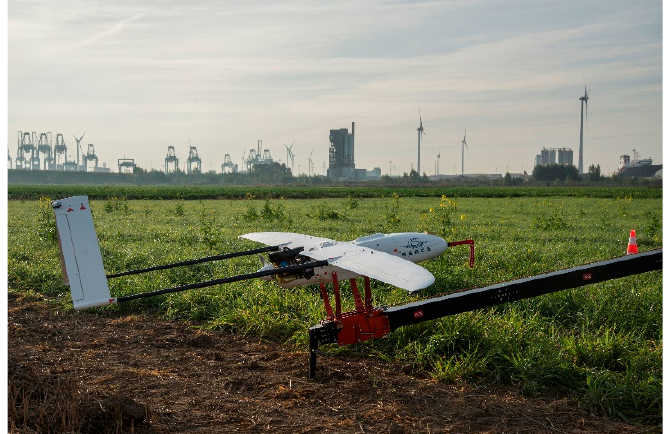
Figure 1. Penguin C UAV from SABCA mounted on the pressurized catapult.